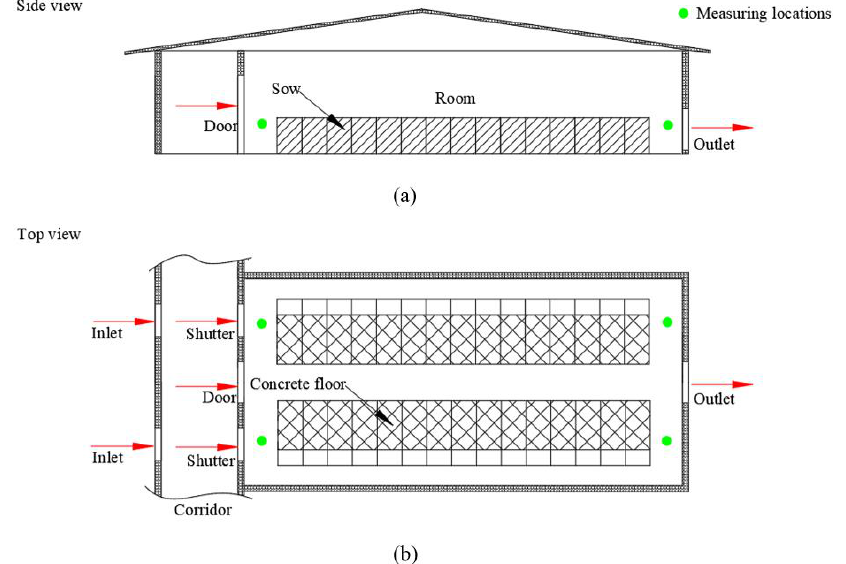
Figure 1. Barn schematic: ( a ) Side view; ( b ) Top view. Barn can house 30 sows, usually 20 – 24 non- pregnant sows per batch. Sow barn is 11.7 m × 7.7 m × 2.5 m. The length, width and height of the crate is 2.2 m × 0.64 m × 1 m. The sow barn has four measuring points, and each measuring point measures the air temperature, relative humidity and air velocity. This research assumed that the difference between different measuring points in environmental parameters is linear (for ex- ample, the green dots in figure ( a ) were set to be 30 °C and 31.5 °C, the environmental param- eters for the 15 sows were 30.1, 30.2, 30.3, 30.4 , …, 31.5 °C), and the environmental parameters were determined at different sow locations based on this assumption. Physiological parameters of the sows in the air outlet area, the air inlet area, and the middle area of the room were